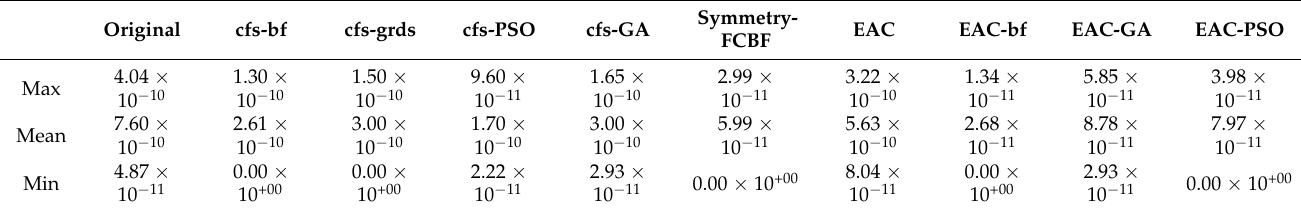
Table 4. Memory consumption (in bytes) of the Hoeffding tree model coupled with ten preprocessing